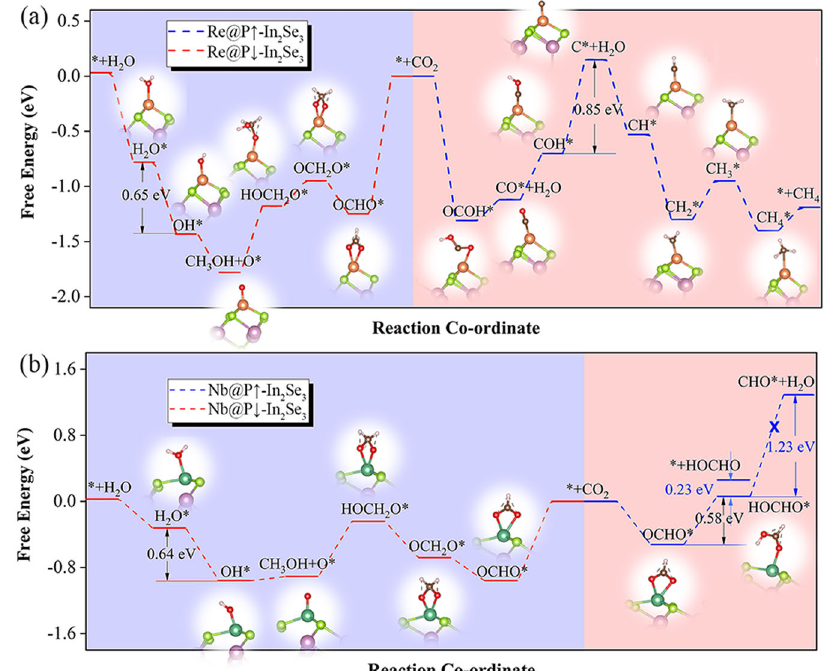
Fig. 5 CO 2 RR paths on Re@In 2 Se 3 and Nb@In 2 Se 3 . Free energy pro fi le for CO 2 electrochemical reduction reactions along the minimum energy path at 0 V ( vs . RHE) on a Re@In 2 Se 3 and b Nb@In 2 Se 3 . The insets show the optimized con fi gurations of the